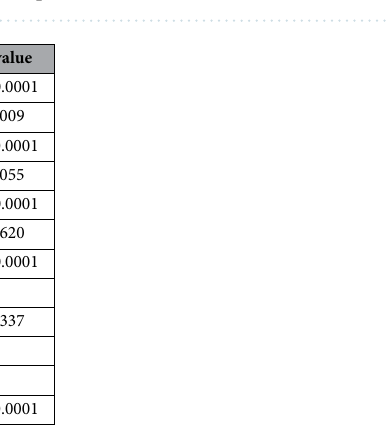
Table 11. The ANOVA table for Merkel number data of CFCT using MWCNTs nanofluid.